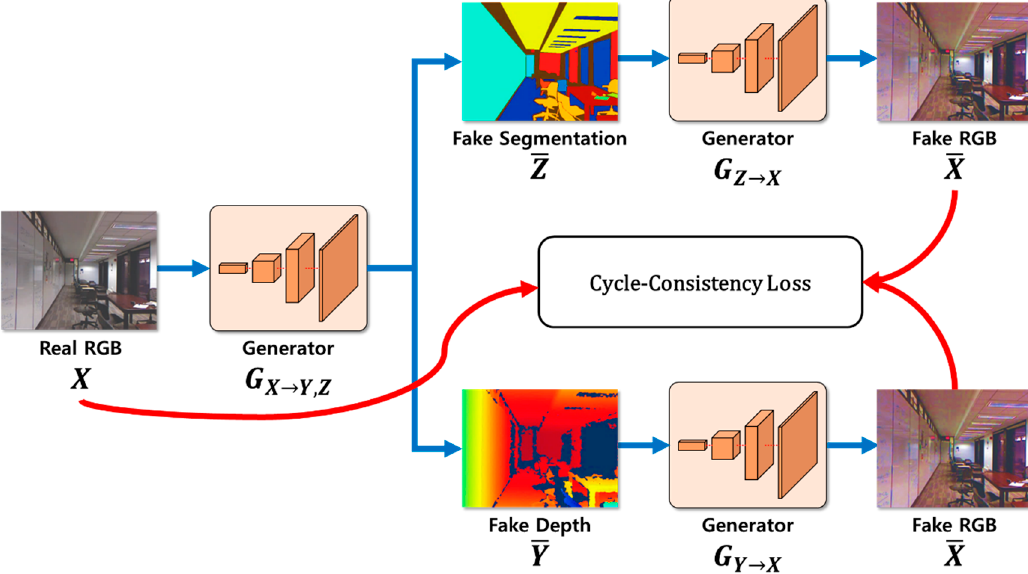
Figure 11. Cycle consistency loss calculation process.